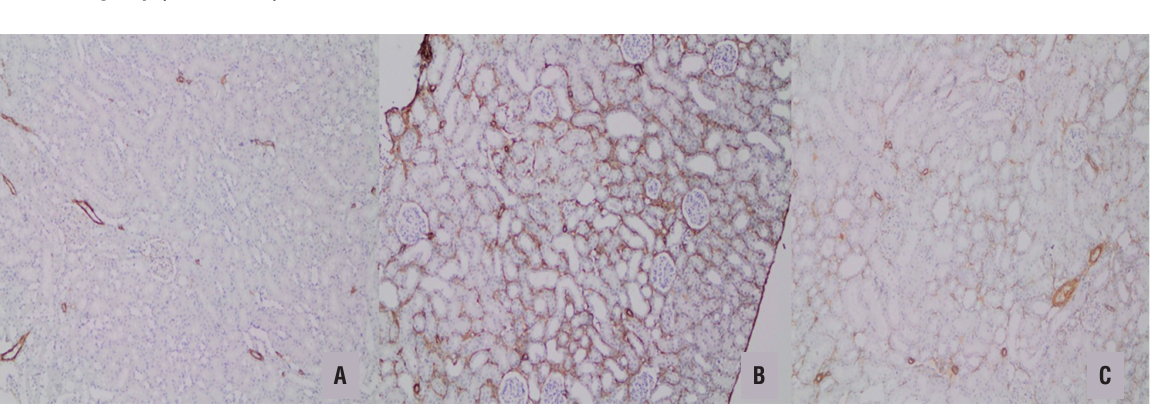
Figure 4 - A) α -SMA staining was not observed in the tubules of the sham group. B) Moderate α-SMA positivity was observed in more than 50% of the tubules in the UUO group. C) mild α-SMA positivity was observed in 25-50% of the tubules in the OPZ-treated group